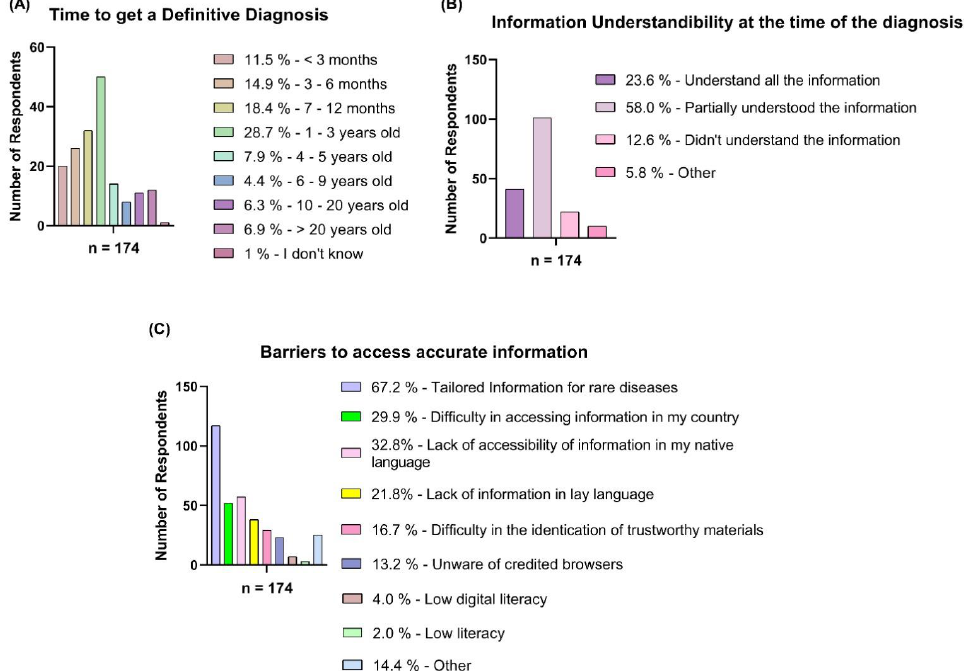
Figure 4. Overview of the answers submitted by the respondents included in this study (CDG family members and caregivers). ( A ) Family members and caregivers’ percentage response to the question ‘’Time to get definitive diagnosis’’. ( B ) Family members and caregivers ’ percentage response to the question ‘’Time of diagnosis information understandability’’. ( C ) Family members and caregivers ’ percentage response to the question ‘’The main barrier to access accurate information’’.